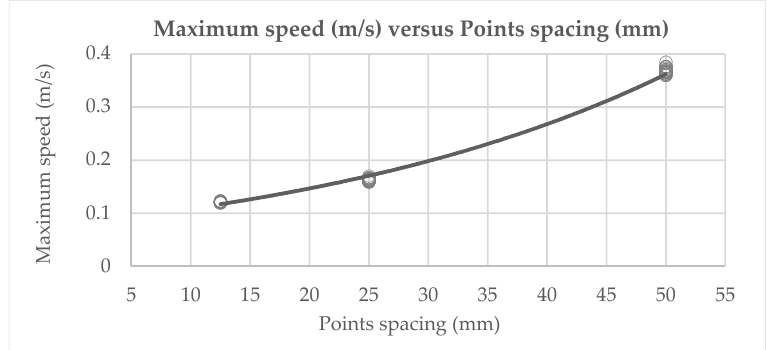
Figure 11. Graph of maximum speed for different point spacings.